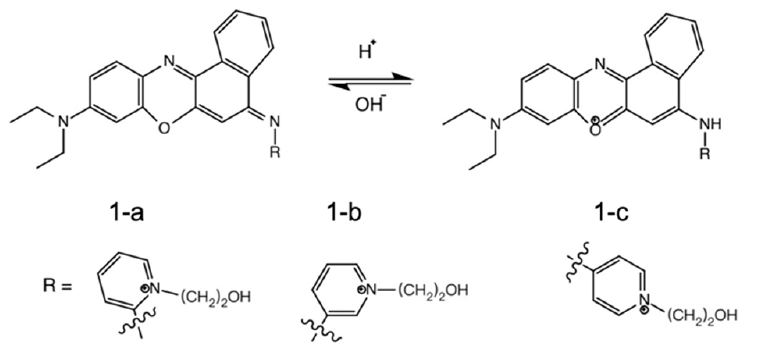
Figure 11. The night-time ozone profile (NIR) fluorescent pH probes based on protonation of amine, three benzo[a]phenoxazine derivates [169]. Table 4. The related properties of these three probes [95].